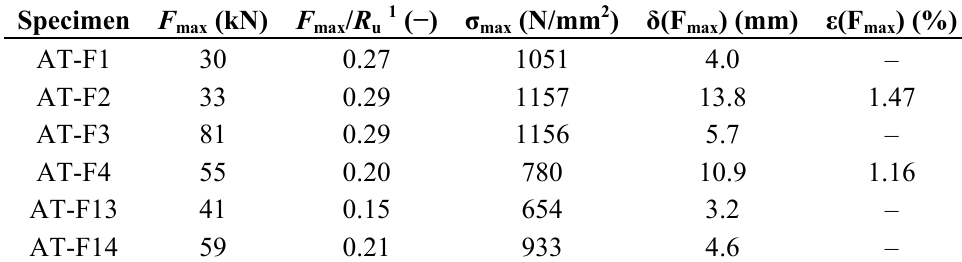
Table 8. Test results of Series